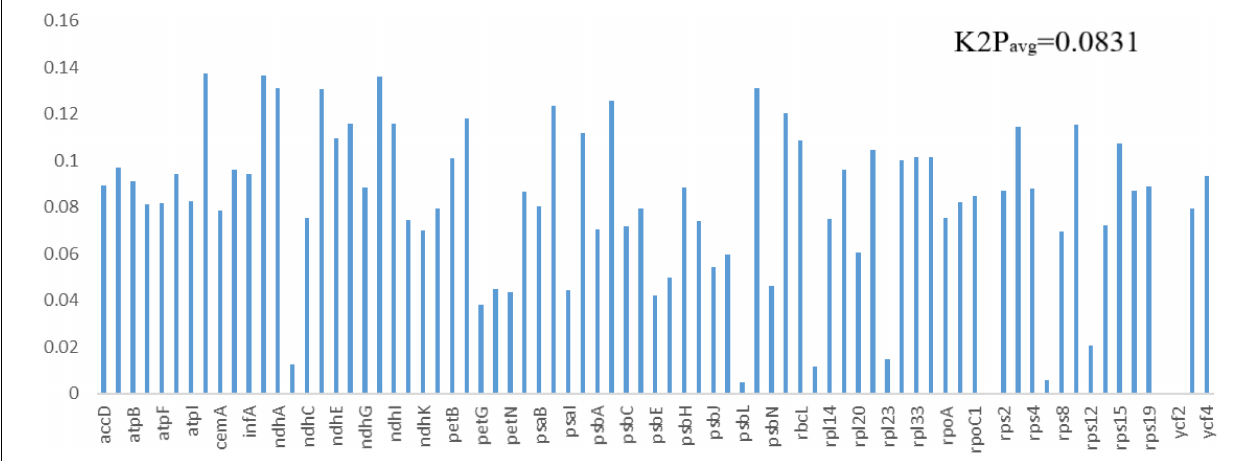
FIGURE 7 | The K2P values estimated for the genes in the cp genomes of the 11 species in the Order Pandanales.